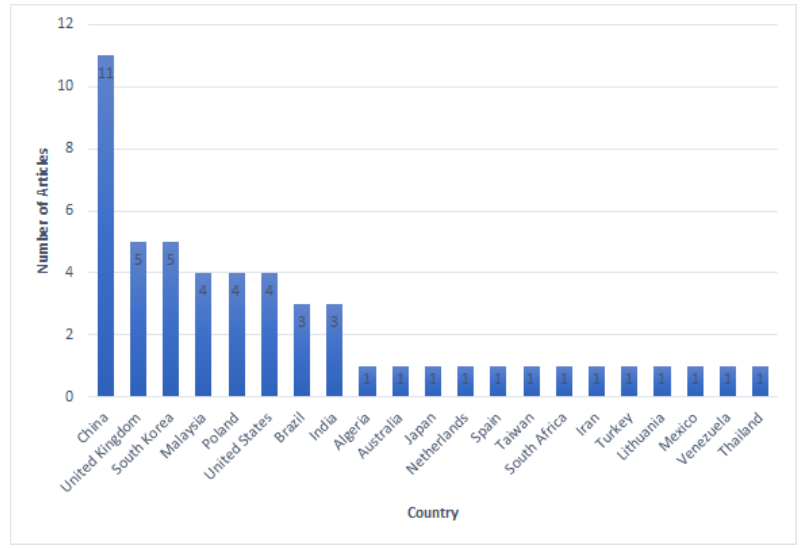
Figure 4. Article distribution by country of